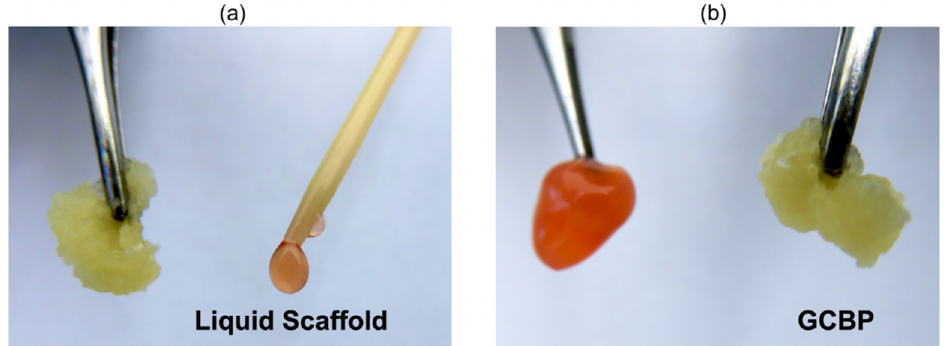
Figure 1. Liquid Scaffold and GCBP: ( a ) Immediately after being prepared from their powdered forms. ( b ) When kept at room temperature for 10–15 min. Liquid Scaffold forms a liquid matrix after reconstitution and transforms into a gel-like state when exposed to physiological temperatures, while GCBP forms into a slurry, semiliquid state that is maintained regardless of temperature changes.